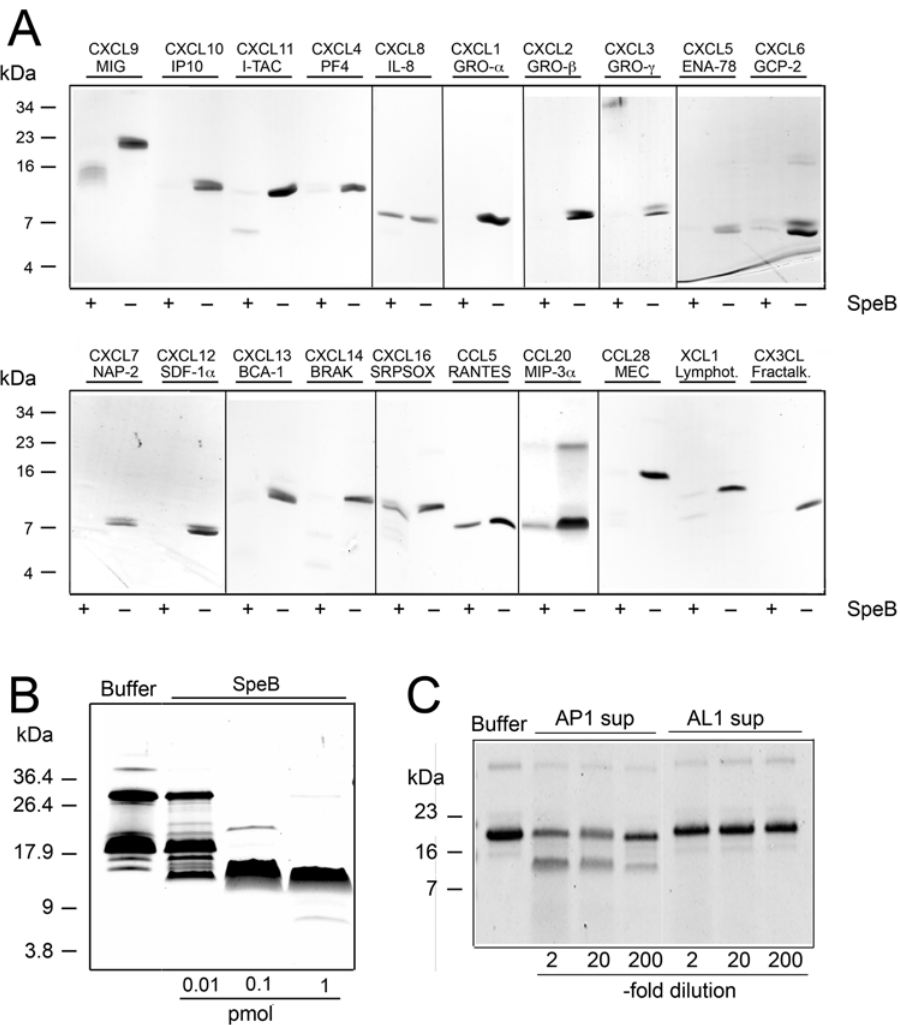
Figure 1. SpeB degrades or processes several human chemokines. Panel A: The streptococcal cysteine proteinase was incubated with human recombinant chemokines and separated on 16.5% Tris-Tricine SDS-PAGE. Chemokines (standardized ligand and common name) are indicated above the panels and presence or absence of SpeB during incubation is indicated with minus or plus signs below the panels. Panel B: Recombinant MIG/CXCL9 was incubated with 1, 0.1, or 1 pmol of active SpeB and separated on 16.5% Tris-Tricine SDS-PAGE. CXCL9 incubated with buffer alone is shown to the left. Panel C: Two micrograms of recombinant human CXCL9 was incubated with dilutions (as indicated) of sterile filtered culture supernatants from wild type S. pyogenes AP1 and SpeB-negative isogenic derivative AL1 and separated on 16.5% Tris-Tricine SDS-PAGE. CXCL9 incubated with buffer alone is shown to the left.